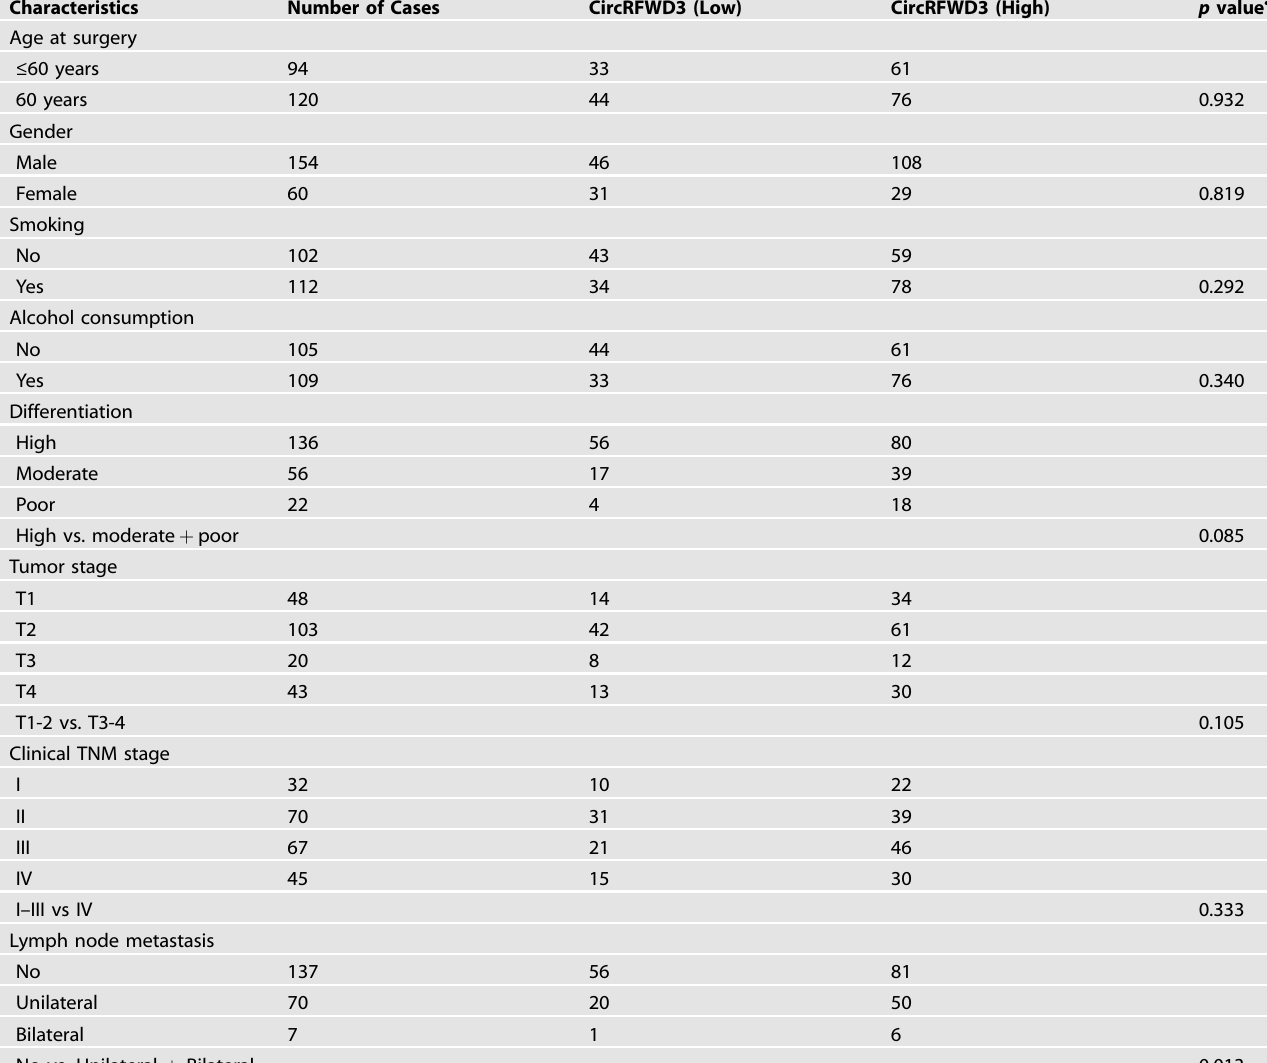
Table 1. Correlation of circRFWD3 in HNSCC with clinicopathological factors including patients and tumor characteristics.